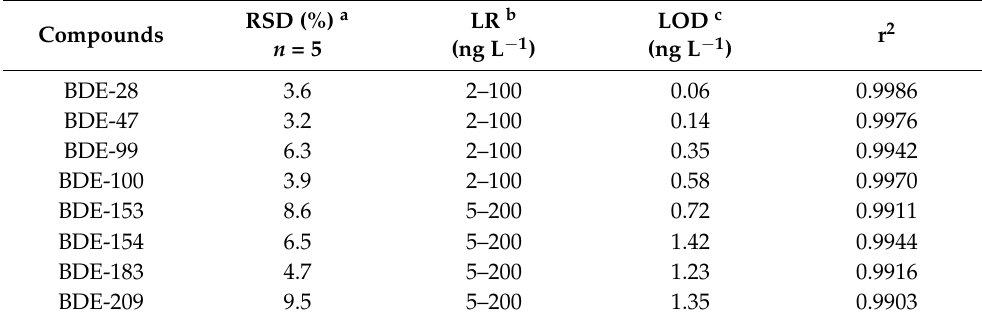
Table 2. Quantitative results of starch-based polymer SPE method and GC-NCI-MS for determination of PBDEs from water samples. Compounds